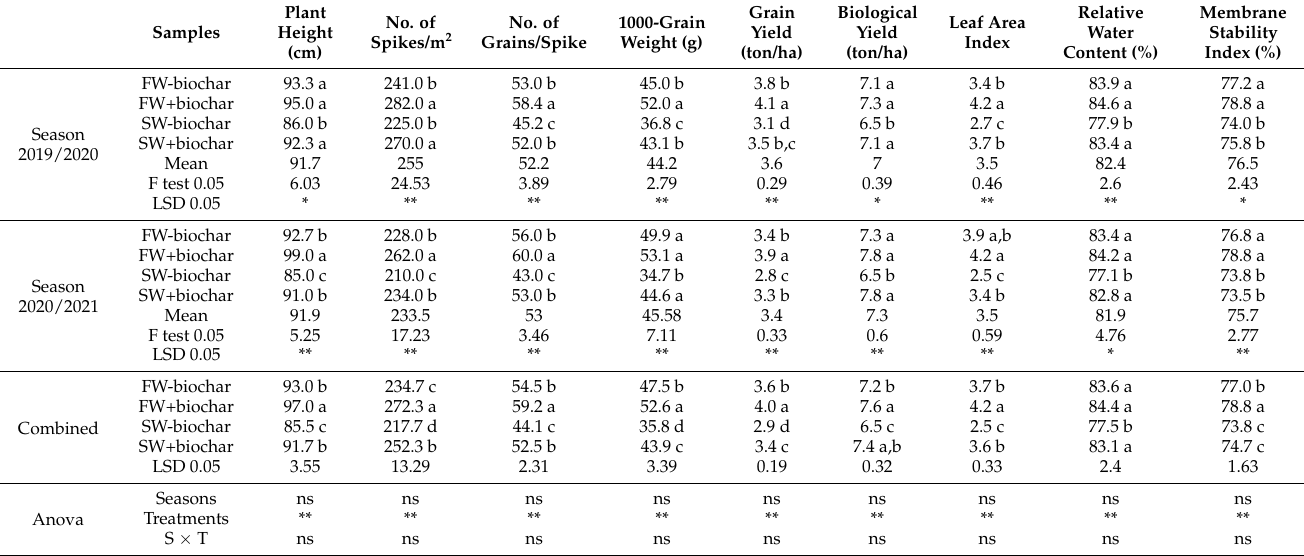
Table 3. Mean of studied traits as affected by water, biochar, and their combination treatments in 2019/2020 and 2020/2021 growing seasons.